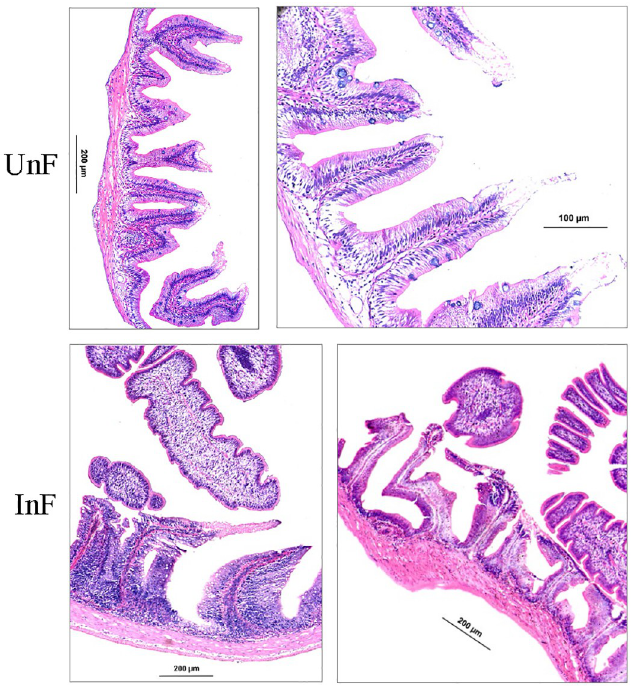
Fig 11. Tissue sections of the foregut in grass carp. UnF, uninfected with S . acheilognathi in the foregut of grass carp; InF, infected with S . acheilognathi in the foregut of grass carp.